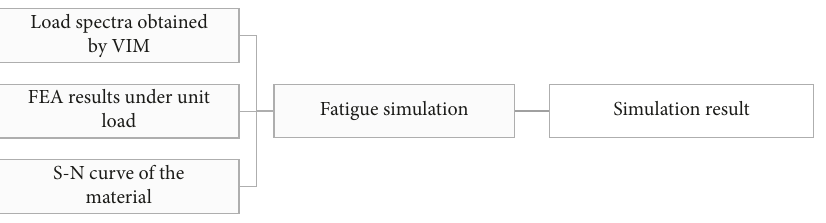
Figure 14: Fatigue analysis